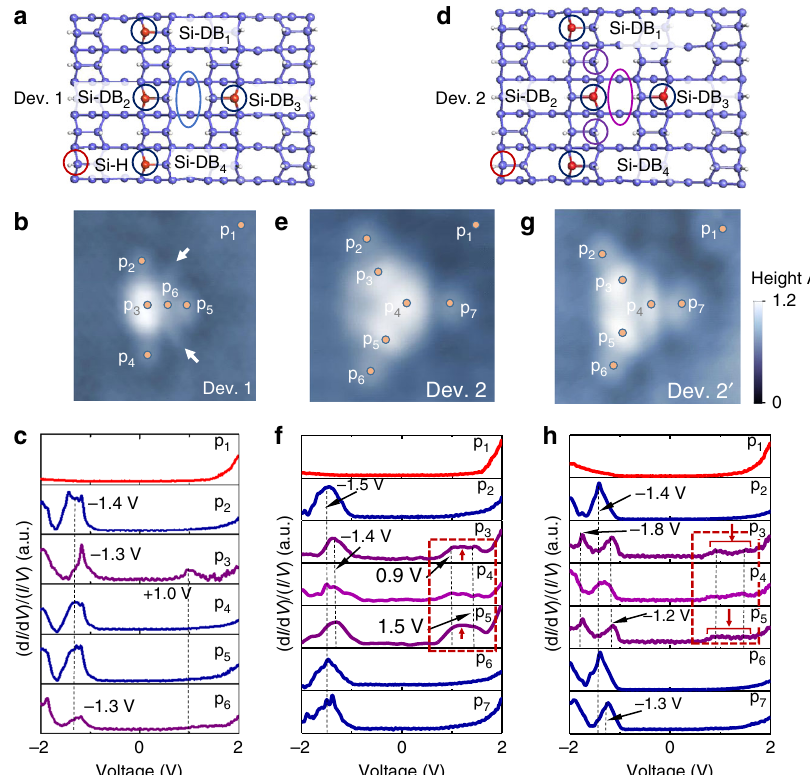
Fig. 5 Electronic structure of the Si-DB devices Dev 1 and Dev 2. a Ball and stick sketch of the four Si-DB structures named Dev. 1. The blue and white balls are Si and H atoms, respectively. The Si atoms without H atom are represented in red. b (32 × 20 Å 2 ) Unoccupied STM topography (1.8 V, 15 pA) of Dev. 1. c Normalized (d I /d V )/( I / V ) curve series acquired on the points p 1 – p 6 as described in b . d Ball and stick sketch of the four Si-DB structure named Dev. 2 with the Si and H atoms colored as in a . e (20 × 20 Å 2 ) Unoccupied STM topography (1.8 V, 15 pA) of Dev. 2 before switching. f Normalized (d I /d V )/( I / V ) curve series acquired on the seven positions p 1 – p 7 as indicated in e . g (20 × 20 Å 2 ) Unoccupied STM topography (1.8 V, 15 pA) of Dev. 2 ′ obtained after the excitation of Dev. 2. h Normalized (d I /d V )/( I / V ) curves series acquired at the seven positions p 1 – p 7 as indicated in